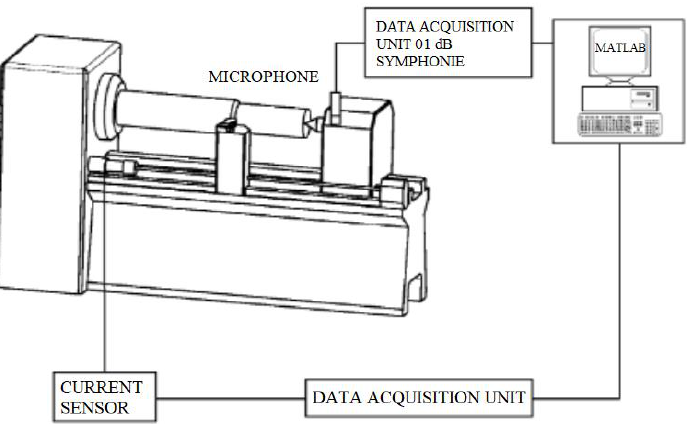
Figure 8. An example for sound based indirect tool condition monitoring system [73].